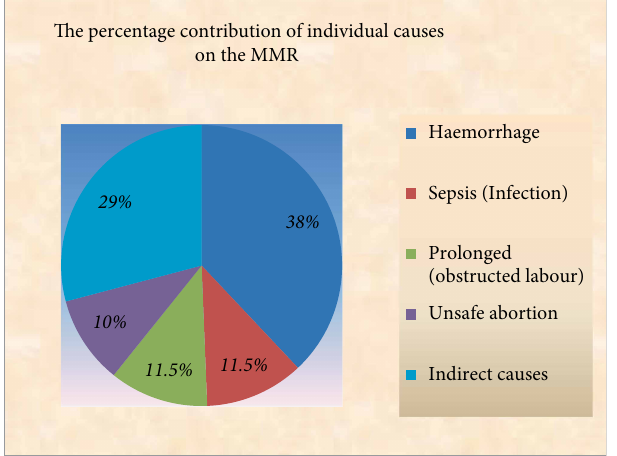
Figure 2: The percentage contribution of individual causes on the MMR.